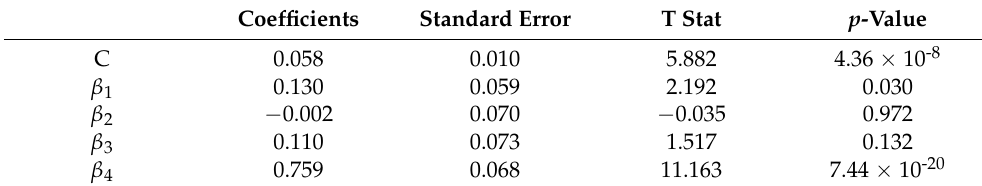
Table 10. Statistical analysis of